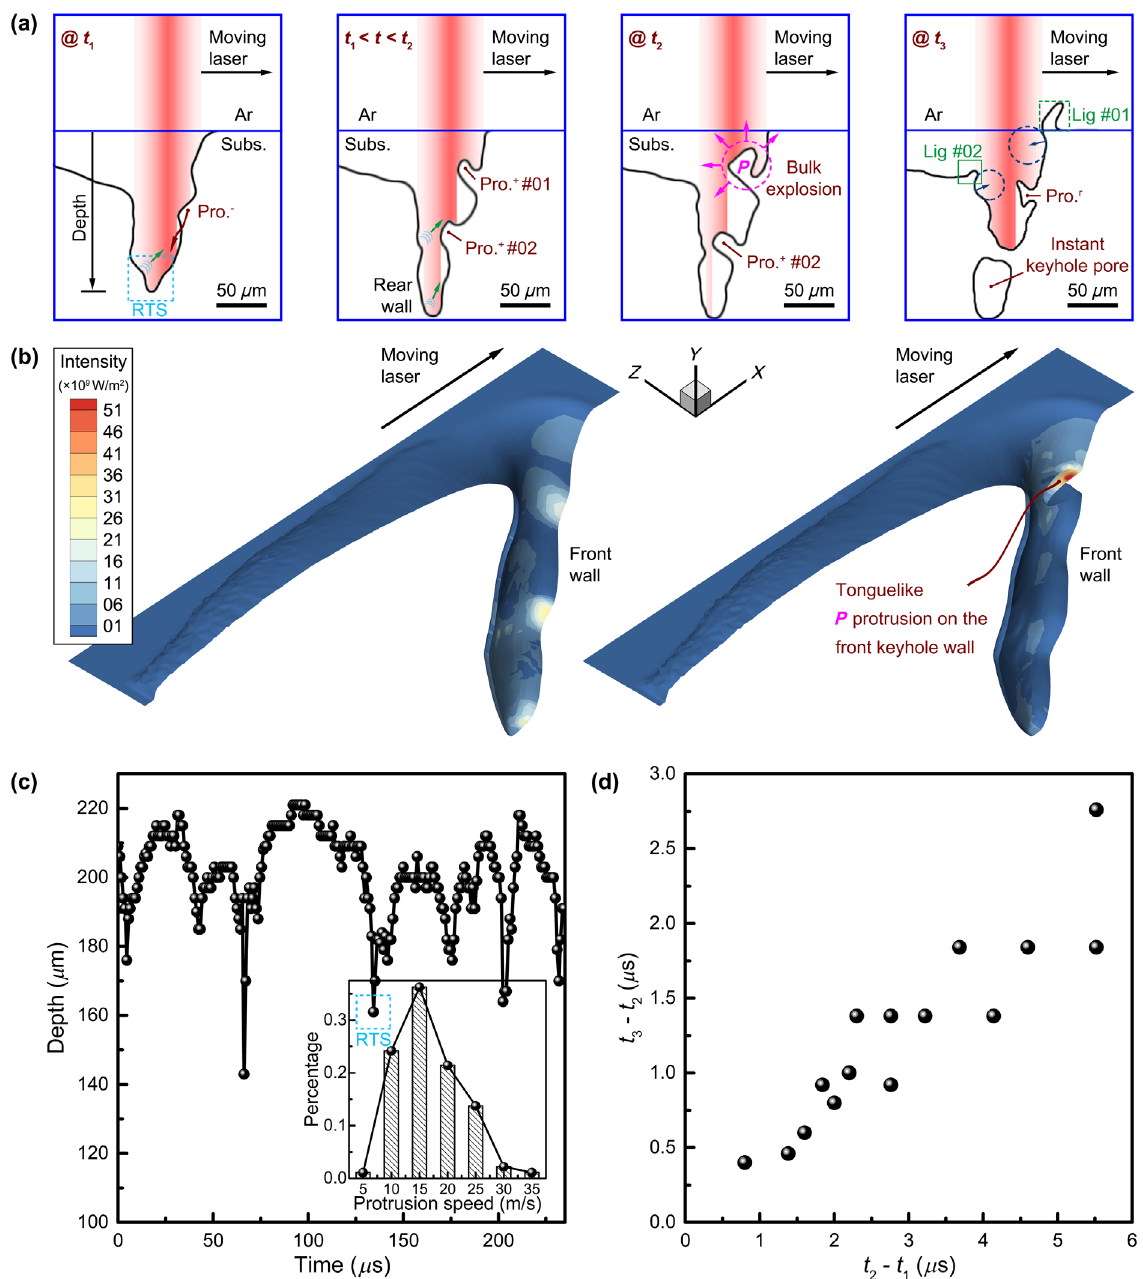
FIG. 2. Bulk explosioninsidea keyhole.(a) Schematic illustrationsofthe sequential events that lead tomelt ligamentation. At t 1 , a keyhole ofreverse-triangle-likeshape(RTS,markedusingskybluedashedrectangle)forms.Therearwallofthisuniquekeyholeisdirectlyexposedto the incident laser beam, and the generated vaporplume (olivegreen arrows) travels upwards towards the frontkeyholewall. Uponimpact,the existing protrusions (e.g., Pro. no. 01 and Pro. no. 02) transform from a dome shape slightly leaning downward (denoted by Pro − : ) to a rod shape tilting upward (denoted by Pro þ : ). At t 2 , a tonguelike protrusion ( P ) forms around the horizontal center of the keyhole with a minikeyholeonitstopsurface.Thebulkexplosionofthetonguelikeprotrusion(purpledashedcircleandarrows)releasesamixtureofgasand fine droplets. At t 3 , the high-momentum mixture reaches the rims of the keyhole. Simultaneously, the local curvatures (dark blue dashed circles) of the keyhole walls change, and thin melt ligaments (Lig, olive green dashed and solid rectangles) appear. After the explosion, the remainsof P protrusion(Pro r : )continuetoflowdownandquicklyvanish.Thelastpanelshowsaninstantkeyholepore.(b)Simulationoflaser absorption intensity with and without the tonguelike protrusion via ray tracing. (c) Keyhole depth as a function of time. Most local minima below a depth threshold correlate with the formation of reverse-triangle-like keyholes. The point marked by the sky blue dashed rectangle is the case shown here. The inset in (c) shows the distribution of the downflow speeds of the protrusions on the front keyhole wall, with the samplingvolumeof182.(d)Relationshipbetweentheactiontimeofthetonguelikeprotrusion t 3 - t 2 anditsformationtime t 2 - t 1 .Datapointsin this plot are collected from x-ray videos (frame rate varies from 1.087 to 5 MHz) of multiple spattering